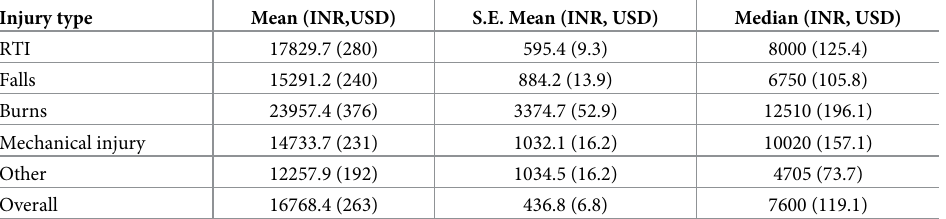
Table 2. Out-of-pocket expenditure for injury related hospitalization in three public sector hospitals in North India.